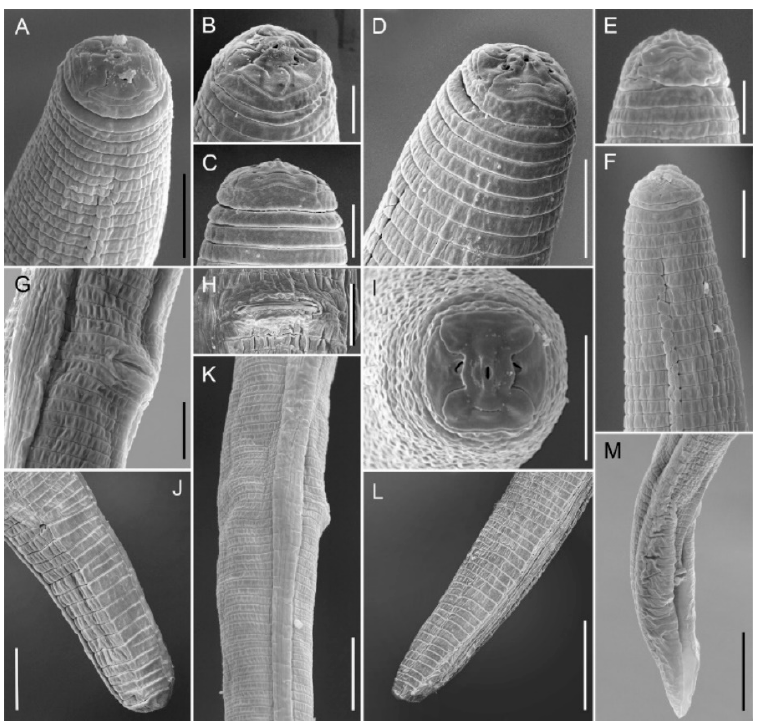
Figure 7. SEM photomicrographs of Pratylenchus vovlasi sp. nov.: ( A – D ), detail of the female lip region; ( E,F ), detail of the male anterior region; ( I ) the female en face view; ( G , H ) the vulval region male tail. Scale bars: ( A , D , F – J ) = 5 µm; ( B , C , E ) = 2.5 µm; ( K – M ) = 10